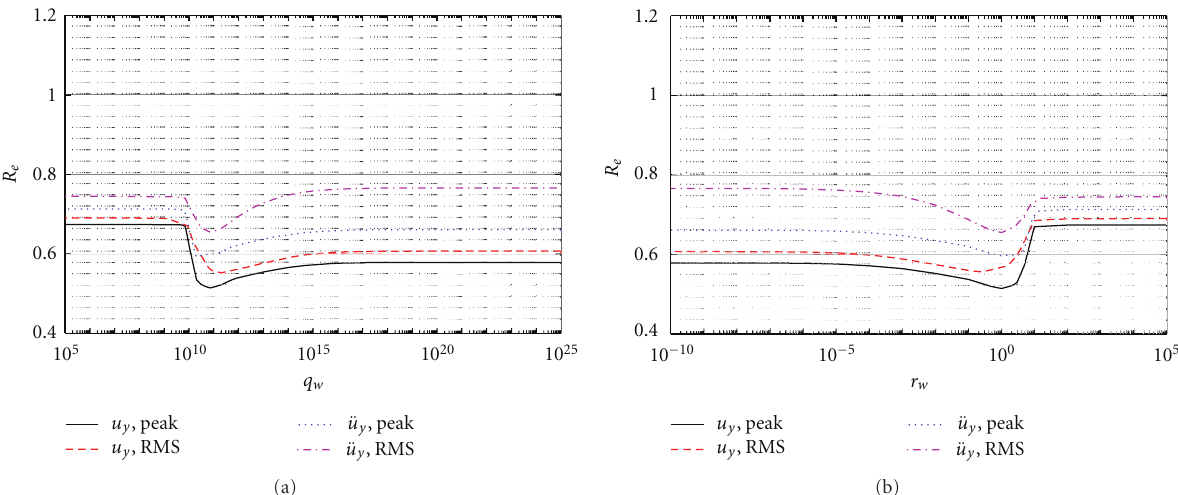
Figure 4: E ff ect of weighting parameters on response ratio, R e for peak and RMS responses under Imperial Valley, 1940 earthquake ( T y = 1s, e x / r = 0).